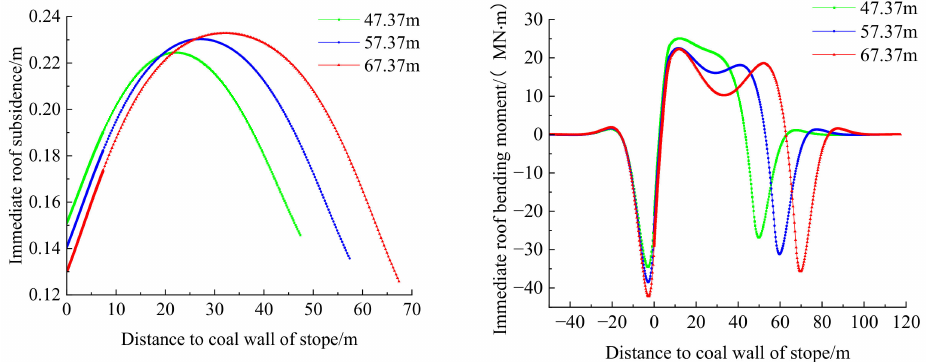
Figure 6. Relationship among advancing distances of the working face, roof subsidence, and bending